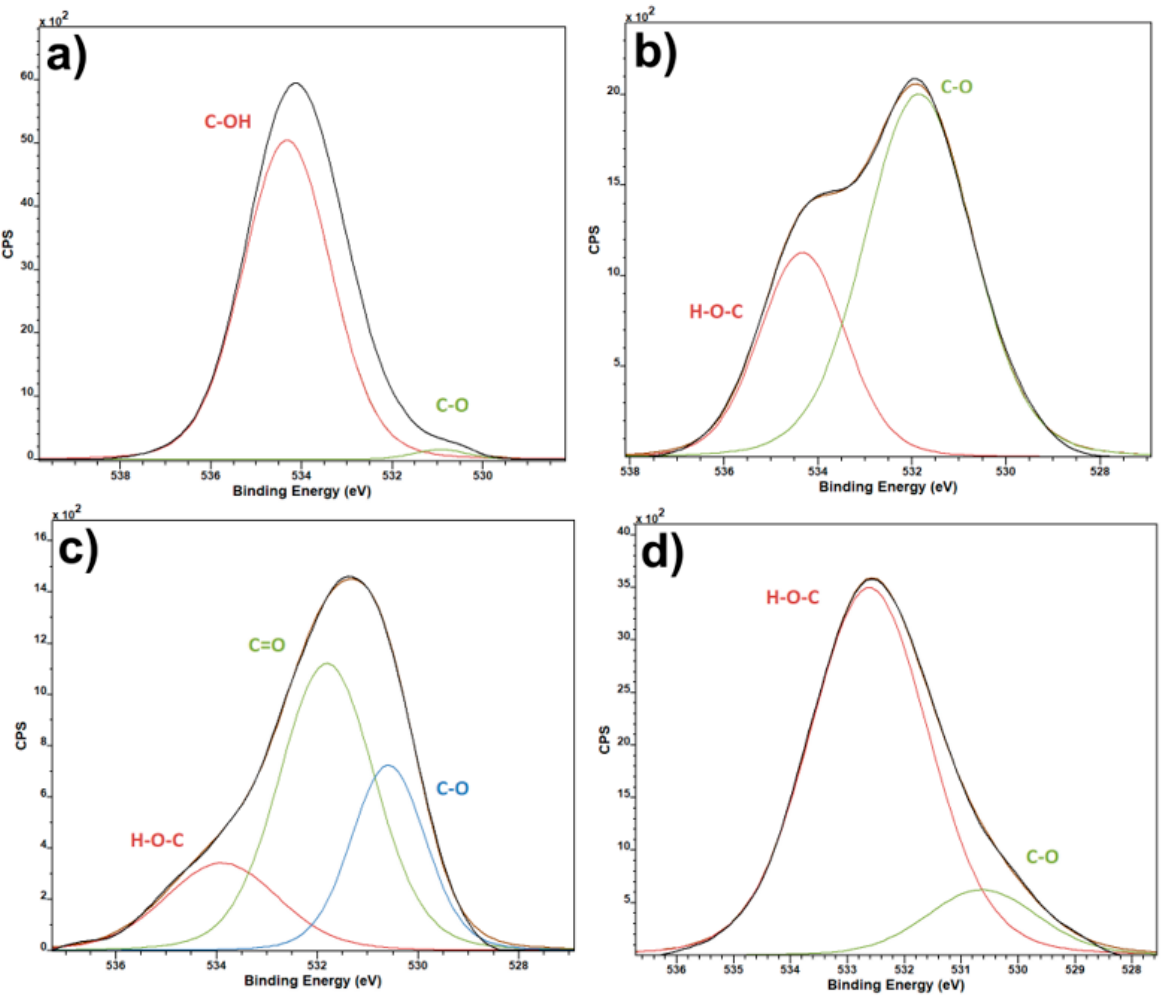
Figure 2. XPS O1 spectra of pure PVDF fibers ( a ) and PVDF fibers with Ca(NO 3 ) 2 ( b ), Mg(NO 3 ) 2 ( c ) and Zn(NO 3 ) 2 ( d ).